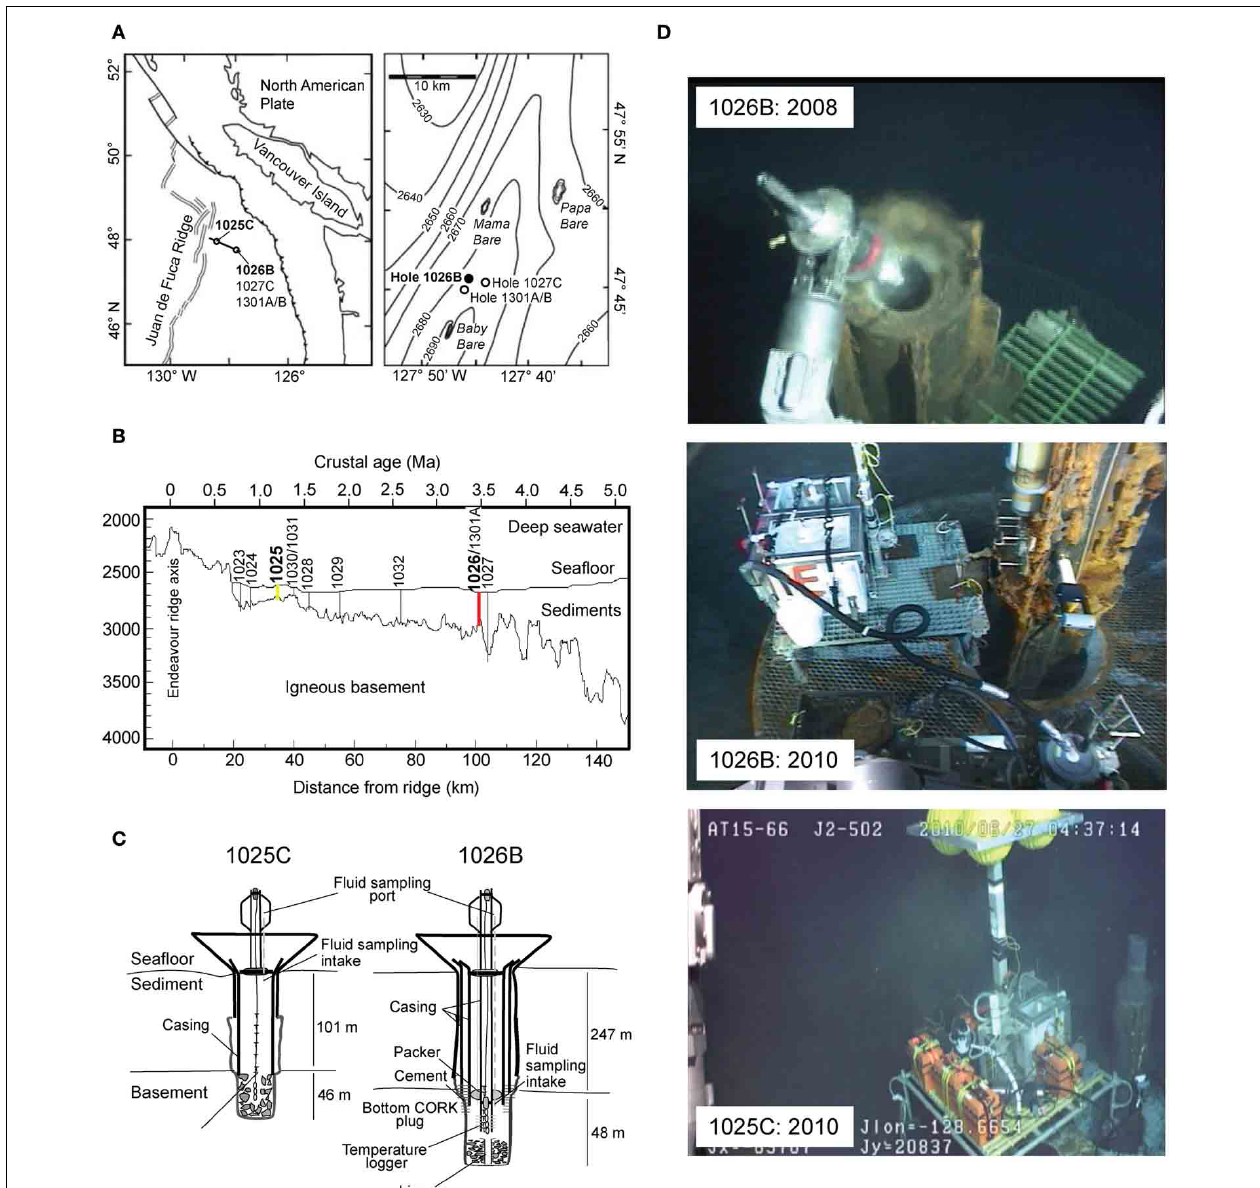
FIGURE 1 | (A) Location of CORK observatory sampling sites on the Juan de Fuca Ridge flank, Pacific Ocean. (B) Cross-sectional diagram of ODP Leg 168 showing depth of basement crust and sediment thickness, basement age and associated distance from ridge axis, and locations of Holes 1025 (yellow) and 1026 (red) in boldface font (modified from Wheat et al., 2004). (C) Schematic diagram of CORKs located at Holes